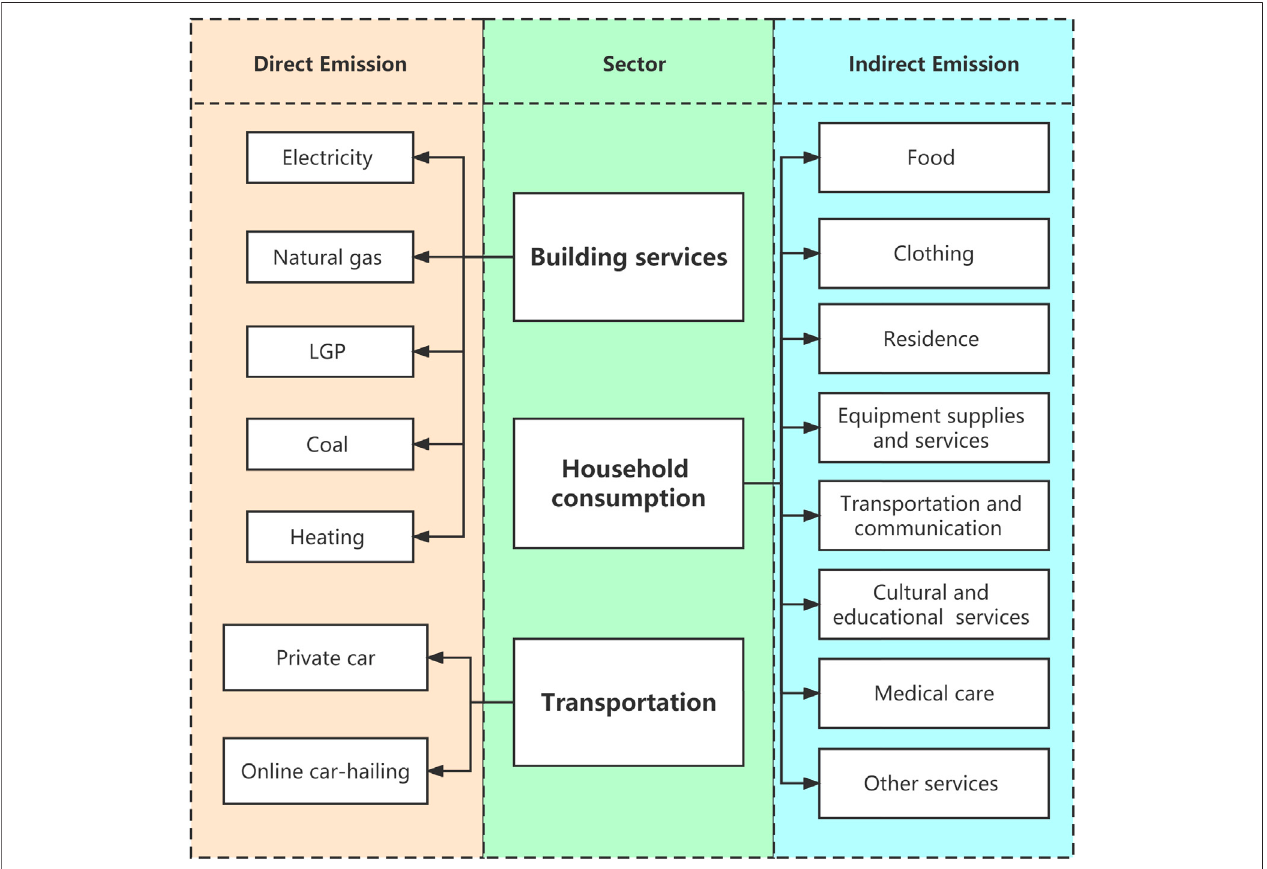
FIGURE 1 | Boundary of household carbon emissions ’ estimation